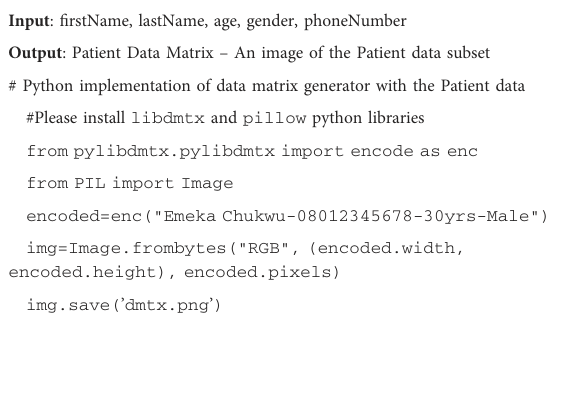
Algorithm 4: Algorithm for of fl ine generation of a unique Patient data